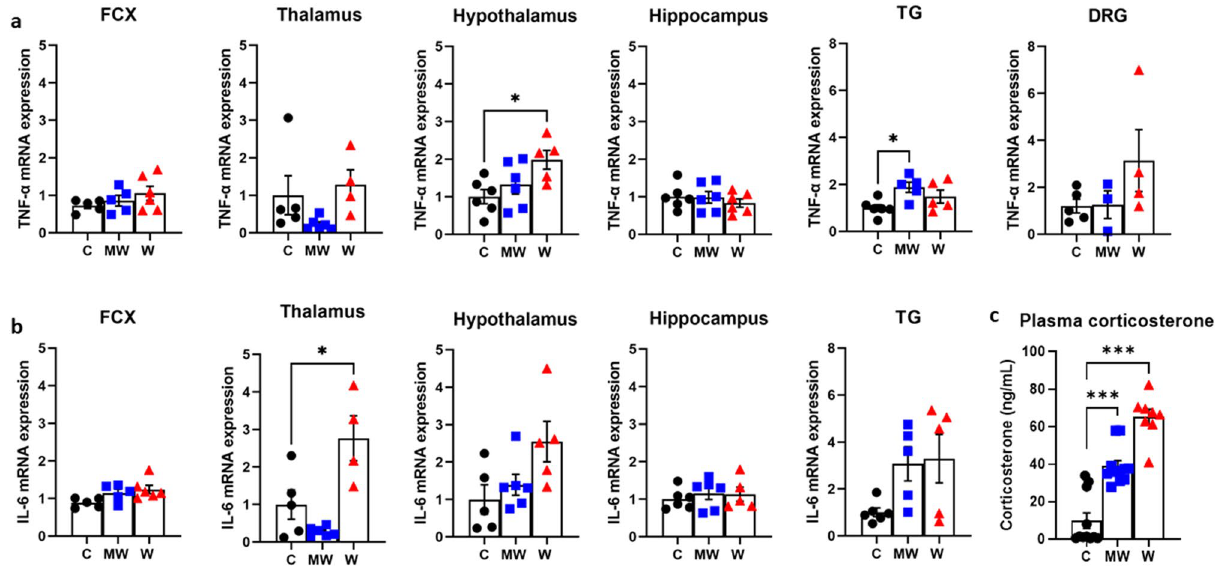
Figure 4. Comparison of RT-PCR results of cytokine expression. In terms of tumor necrosis factor alpha (TNF-α) expression, no significant changes were seen in the frontal cortex (FCX), thalamus, hippocampus, and dorsal root ganglion (DRG). However, significant increases in the hypothalamus were observed in the water (W) group and the trigeminal ganglion (TG) in the mesh wire (MW) compared to the control (C) group ( a ). Higher expressions of interleukin-6 (IL-6) were found in the thalamus of the W group only ( b ). Plasma corticosterone levels were higher across all predictable chronic mild stress (PCMS) groups than the control ( c ). N = 4–6 per group (RT-PCR); N = 8–11 per group (Corticosterone); * p < 0.05, *** p < 0.001; one-way ordinary ANOVA followed by Dunnett’s multiple comparison test. Data are presented as means ± SEM.